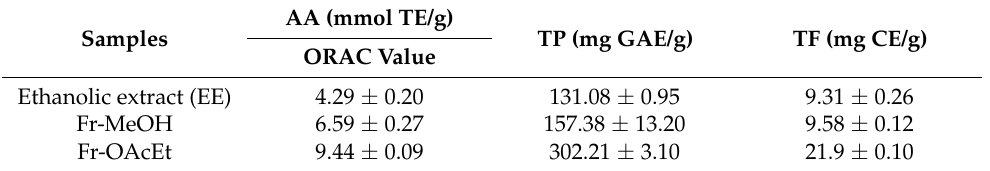
Table 1. Antioxidant activity (ORAC), total phenolic and total flavonoids contents for Chamaecrista diphylla leaves ethanolic extract (EE), Fr-MeOH and Fr-OAcEt.